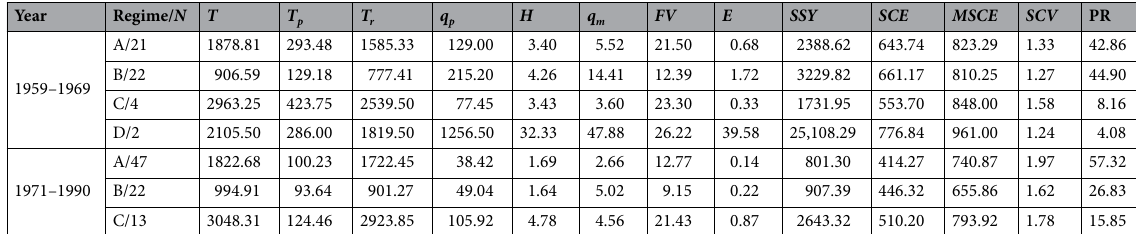
Table 2. Descriptive statistics of the characteristics of event-based flood flows and sediment under different flood regimes in 1961–1990 (excluding 1970). Regime A: short flood duration and low erosive energy; Regime B: short flood duration and high erosive energy; Regime C: long flood duration and low erosive energy; Regime D: long flood duration and high erosive energy. N , the number of recorded flood events in the regime; PR, the proportion of the number of recorded flood regimes to the total flood number at different times, in %. Other indicators are as defined in Table